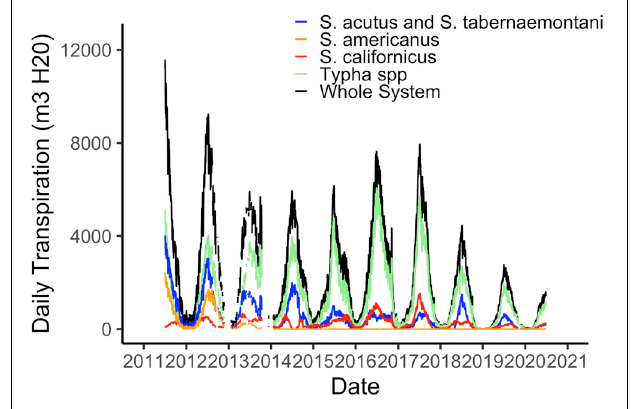
FIGURE 3 | Total daily water losses via plant transpiration from the 21 ha marsh system for all species combined and for the four species groups defined by the phenometric models (Weller et al.,